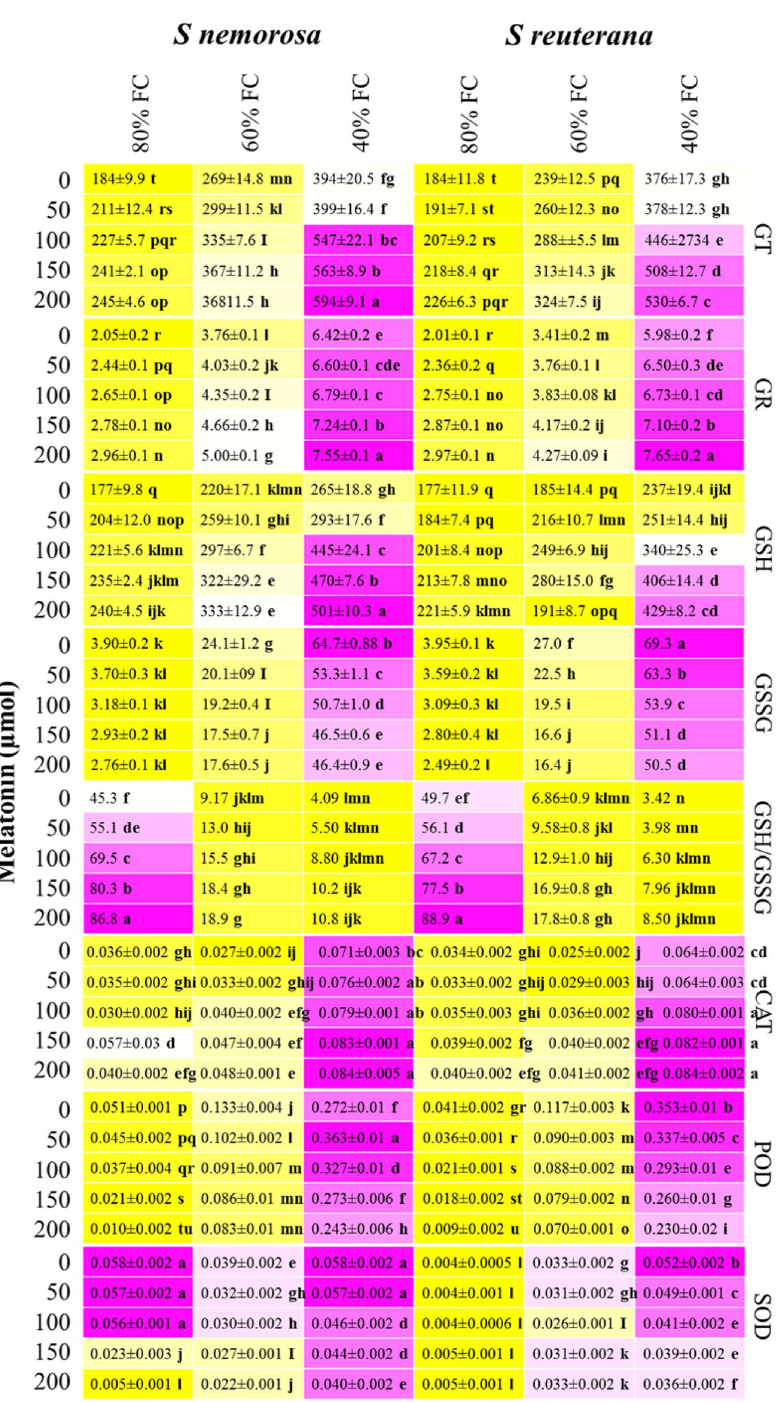
of β - caryophyllene, Germacrene- B, spathulenol and cis- β - farnesene to a significant extend and more than the other treatments (Table 3), while for Salvia reuterana , 150 µ M of melatonin enhanced the accumulation of hexyl acetate and aromadendrene and 200 µ M of melatonin caused an increase in (E) - β - Ocimene, α - gurjnnene and